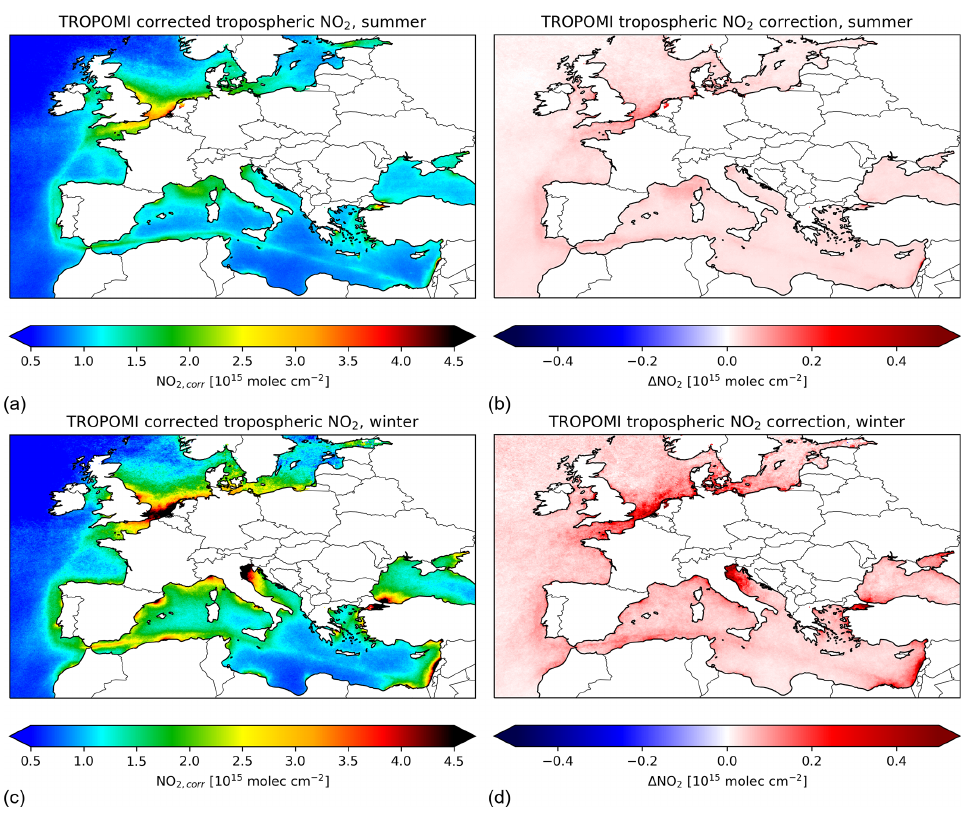
Figure 8. Effect of DNN correction: (a) corrected TROPOMI data for summer (May–September) 2019, (b) change in NO 2 columns by the correction for the same period (v2.1p–v1.3), (c) corrected TROPOMI data for winter (November–April) 2019/2020, and (d) change in NO 2 columns by the correction for the same period (v2.1p–v1.3). Land areas are whitened out for clarity.